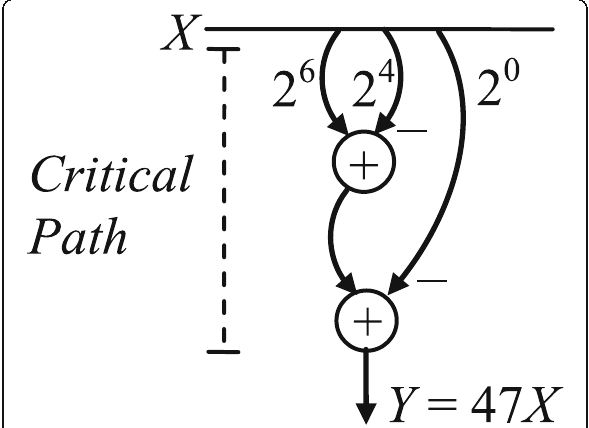
Fig. 3 Implementation structure of the product 47 X with constant 47 expressed in CSD using two input